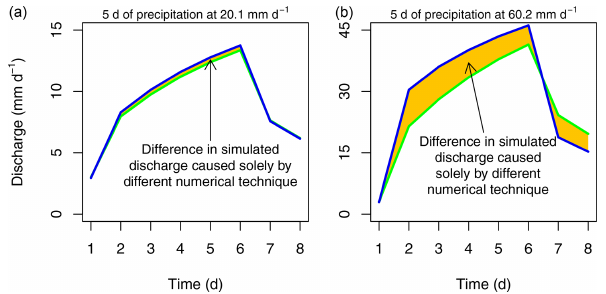
Figure 1. Illustration of the impact of precipitation intensity on dif- ferences between discharge simulations from the same model but with two different numerical techniques. Discharge hydrographs are shown resulting from two different numerical methods, indicated by blue and green. These are the fixed step explicit Heun and adaptive implicit Heun methods, respectively, as discussed in Sect. 2. The only difference between the left and right plots is that the precipita- tion intensity is 3 times greater during days 2 through 6 for the right plot. With this figure, we do not suggest that any particular climate’s precipitation will triple; this is merely used to demonstrate the re- lationship between precipitation intensity and potential numerical